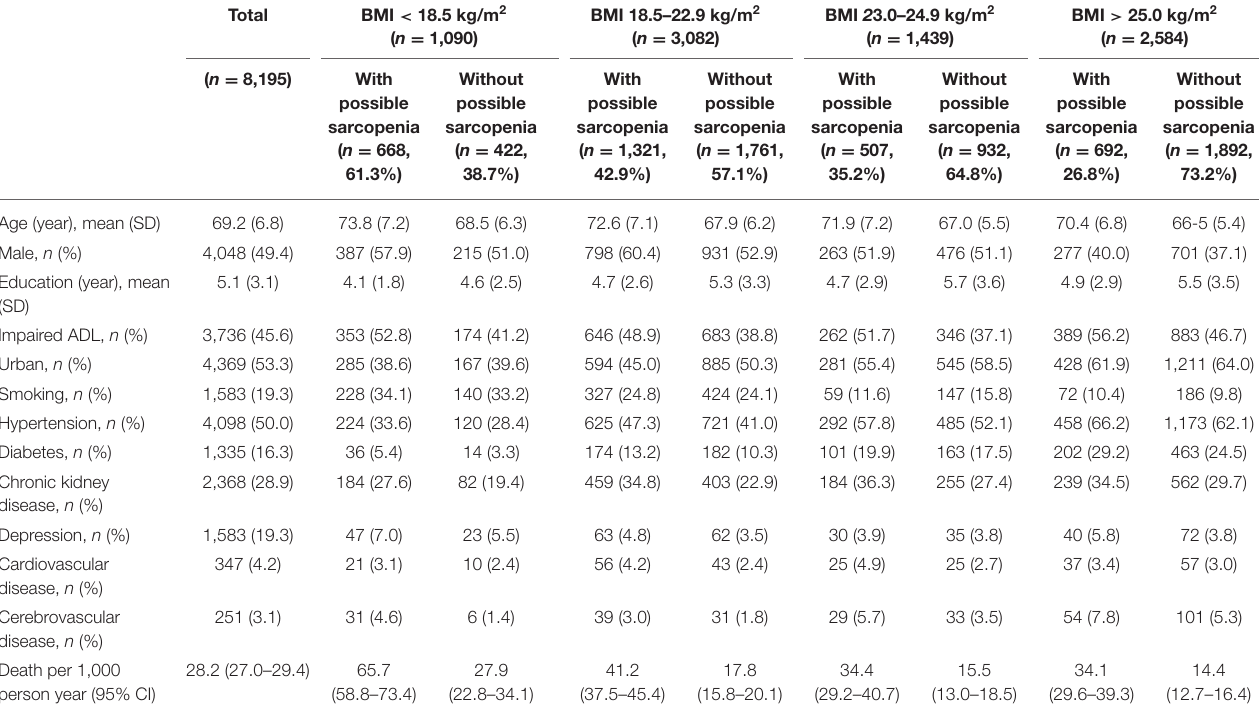
TABLE 1 | Sociodemographic, functional, lifestyle, clinical, mental health, and mortality characteristics of study participants for different body mass index (BMI) ranges compared between Thai older adults with and without possible sarcopenia ( N =